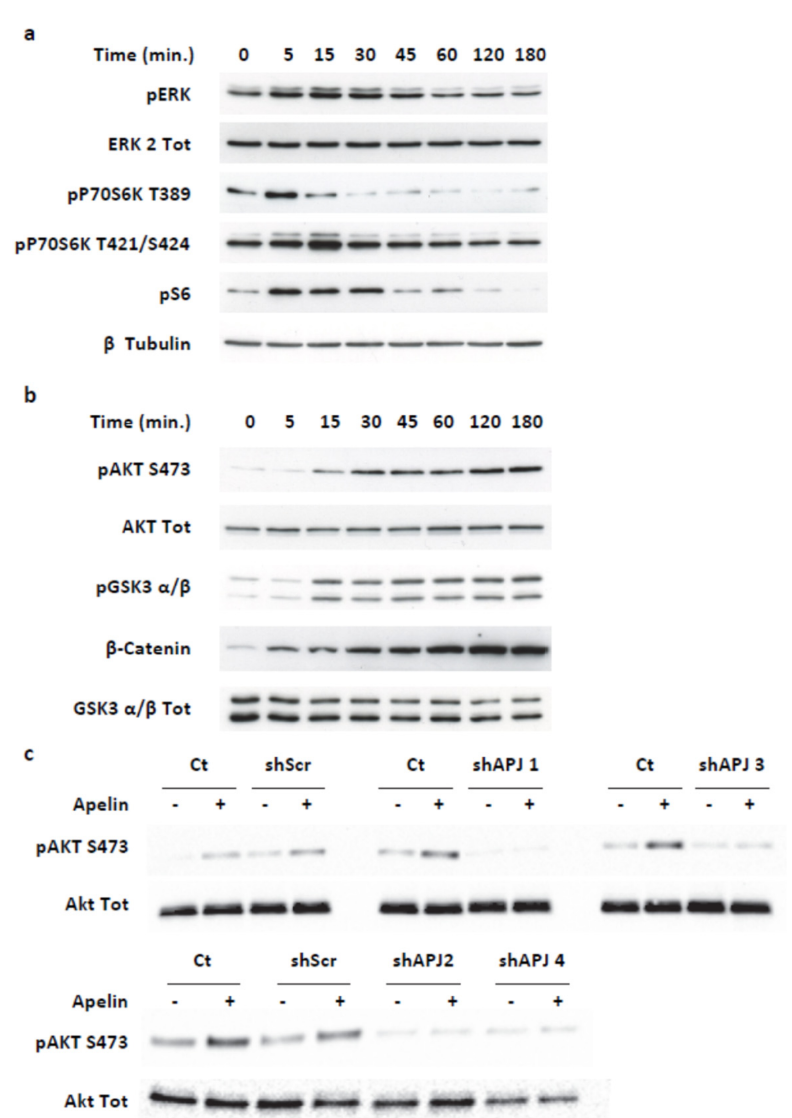
Figure 4. Apelin stimulates transient and long-lasting signaling pathways in the human pancreatic tumor cell line MiaPaCa-2. ( a ) Apelin transiently activates ERK/p70S6 kinase pathways. MiaPaCa-2 cell line endogenously expressing hAPJ were serum-starved for 20 h. After stimulation with 500 nM apelin for the indicated times, they were lysed and analyzed by SDS-PAGE and immunoblotted. Western blots were probed with anti-Thr202/Tyr204 phosphorylated ERK1 and ERK2, anti-ERK2, anti-Thr389 phosphorylated p70S6 kinase, anti-Ser 240/Ser 244 phosphorylated S6 protein and anti- β - tubulin. Representative Western blots from n = 4. ( b ) Apelin promotes long lasting phosphorylation of Akt/GSK3 and β -catenin stabilization. Lysates from MiaPaCa-2 cell line, stimulated at different time points with apelin such as in ( a ), were immunoblotted with anti-Ser473, anti-Akt, anti-Ser9/Ser21 phosphorylated GSK3 alpha/beta, anti-GSK3 alpha/beta and anti- β -Catenin. Representative Western blots from n = 4. ( c ) Loss of APJ protein expression abolishes apelin response in human pancreatic tumor MiaPaCa-2 cells. MiaPaCa-2 cells stably expressing scrambled shRNA (ShScr) or different shRNA directed against hAPJ (shAPJ 1, shAPJ2, shAPJ 3, shAPJ4) were starved of serum for 20 h and then stimulated with apelin (500 nM) for 3 h. Western blots analysis of phospho-Ser 473 Akt and total Akt were realized. Representative Western blots from n =